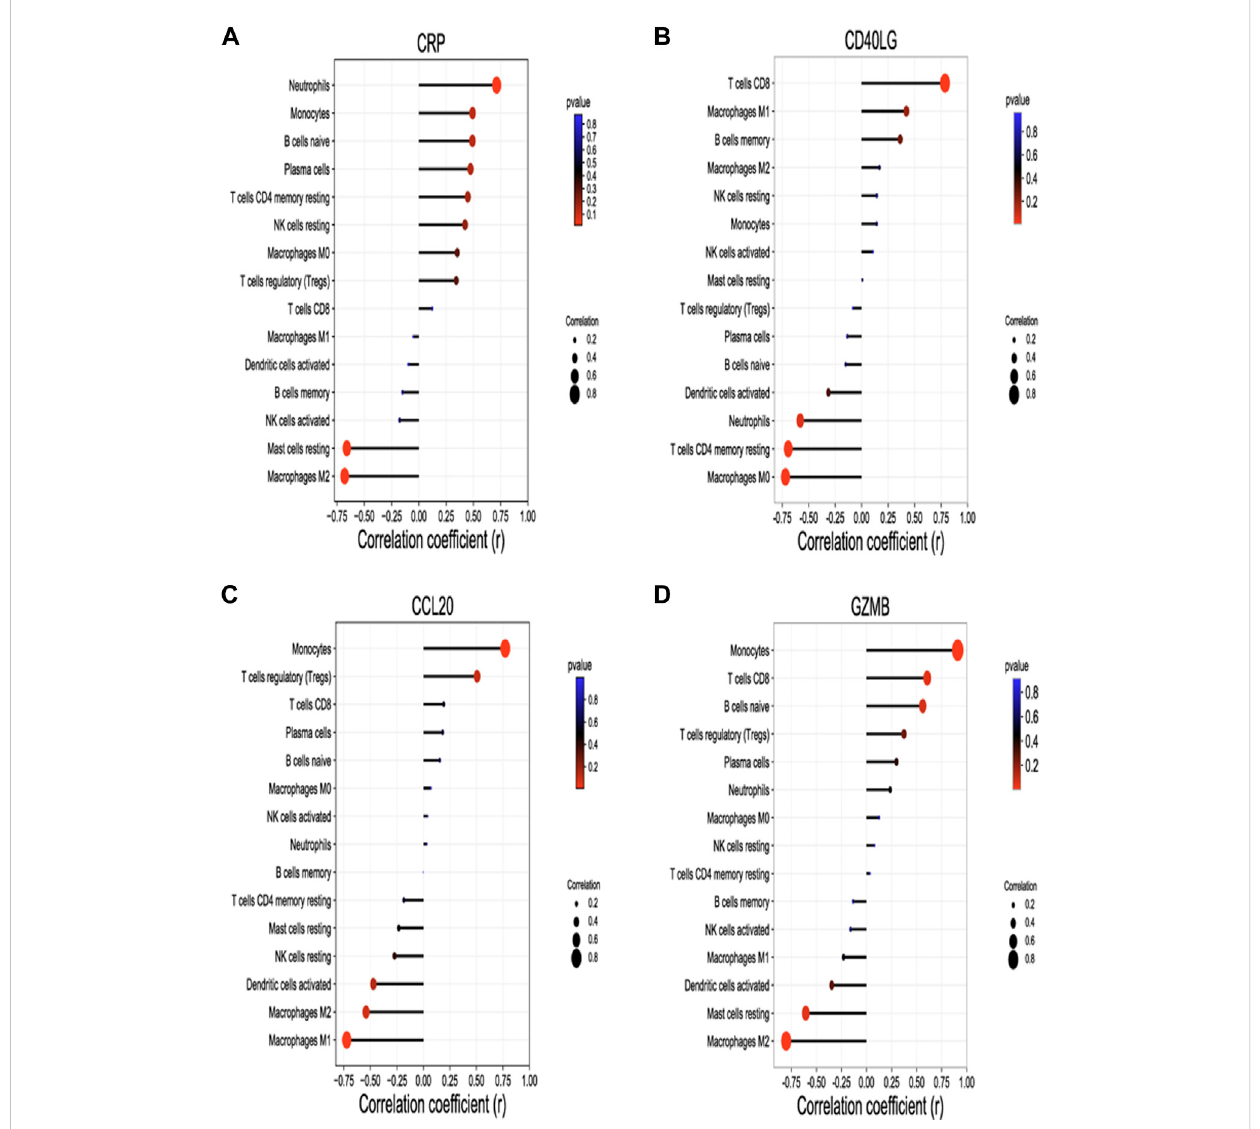
FIGURE 5 Correlation between hub genes and Immune in fi ltration cells. Spearman ’ s correlation analysis between CRP (A) , CD40LG (B) , CCL20 (C) , GZMB (D) and in fi ltrating immune cells, respectively.The four hub genes were validated by RT-qPCR. The size of the dots represents the strength of the correlation between genesand immune cells; thelarger thedots, thestronger thecorrelation. The colorofthedotsrepresents thep-value, theredder thecolor,the lower the p-value. p < 0.05 was considered statistically signi fi cant. CRP , C-Reactive Protein; CCL20 , C-C Motif Chemokine Ligand 20; CD40LG , CD40 Ligand; GZMB , Granzyme